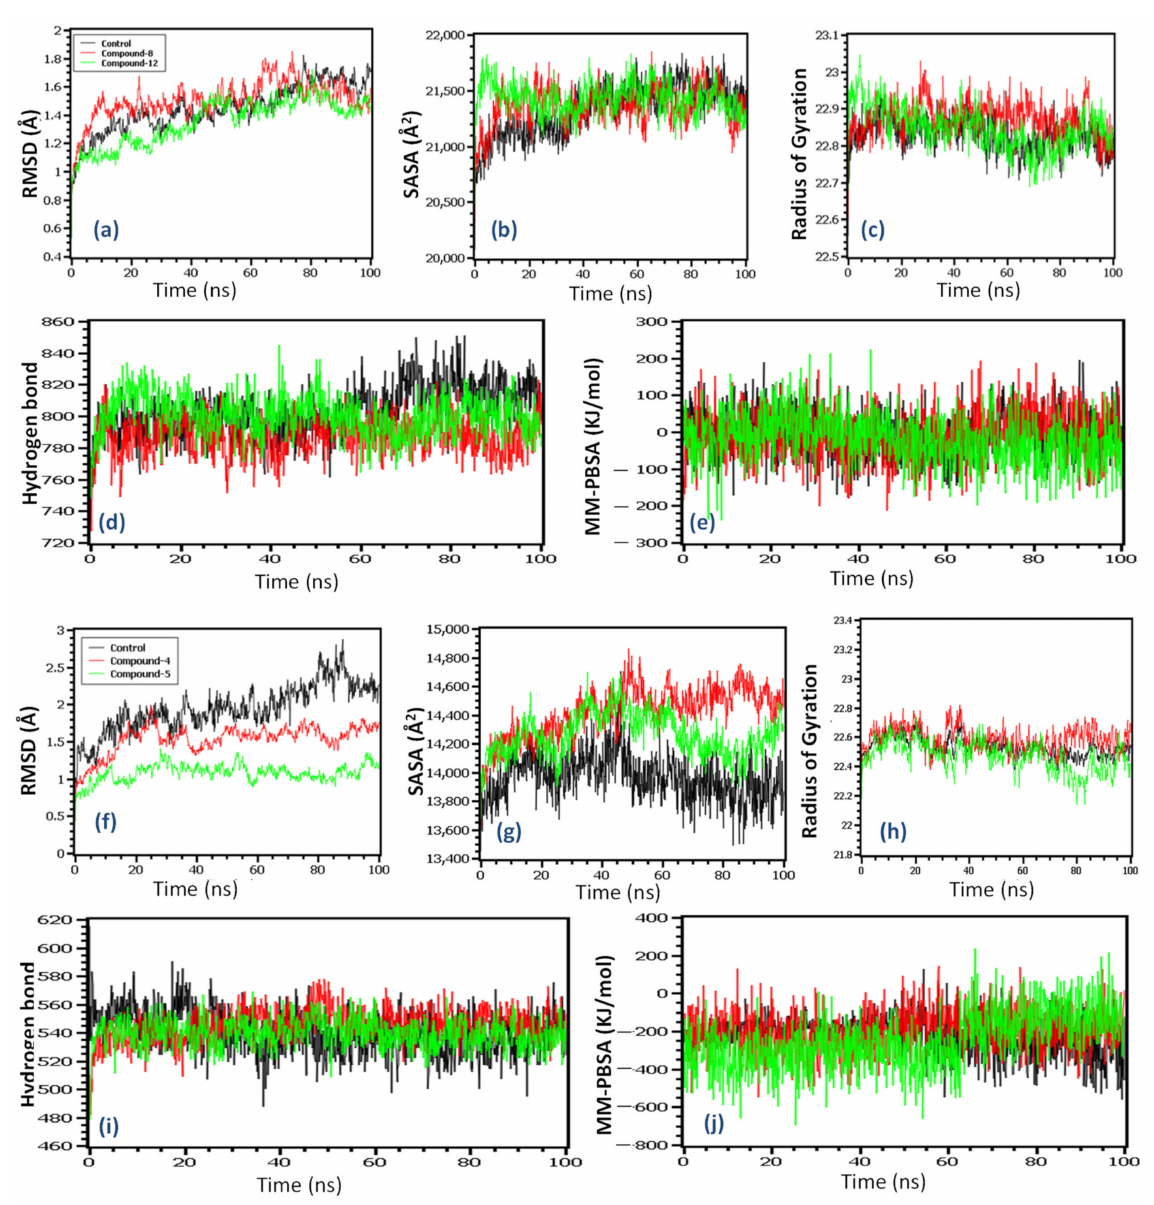
Figure 7. Molecular dynamics simulation of compounds—4UYL complex ( a ) RMSD, ( b ) SASA, ( c ) Rg, ( d ) hydrogen bond, and ( e ) MM-PBSA; compounds—6LU7 complex ( f ) RMSD, ( g ) SASA, ( h ) Rg, ( i ) hydrogen bond, and ( j )